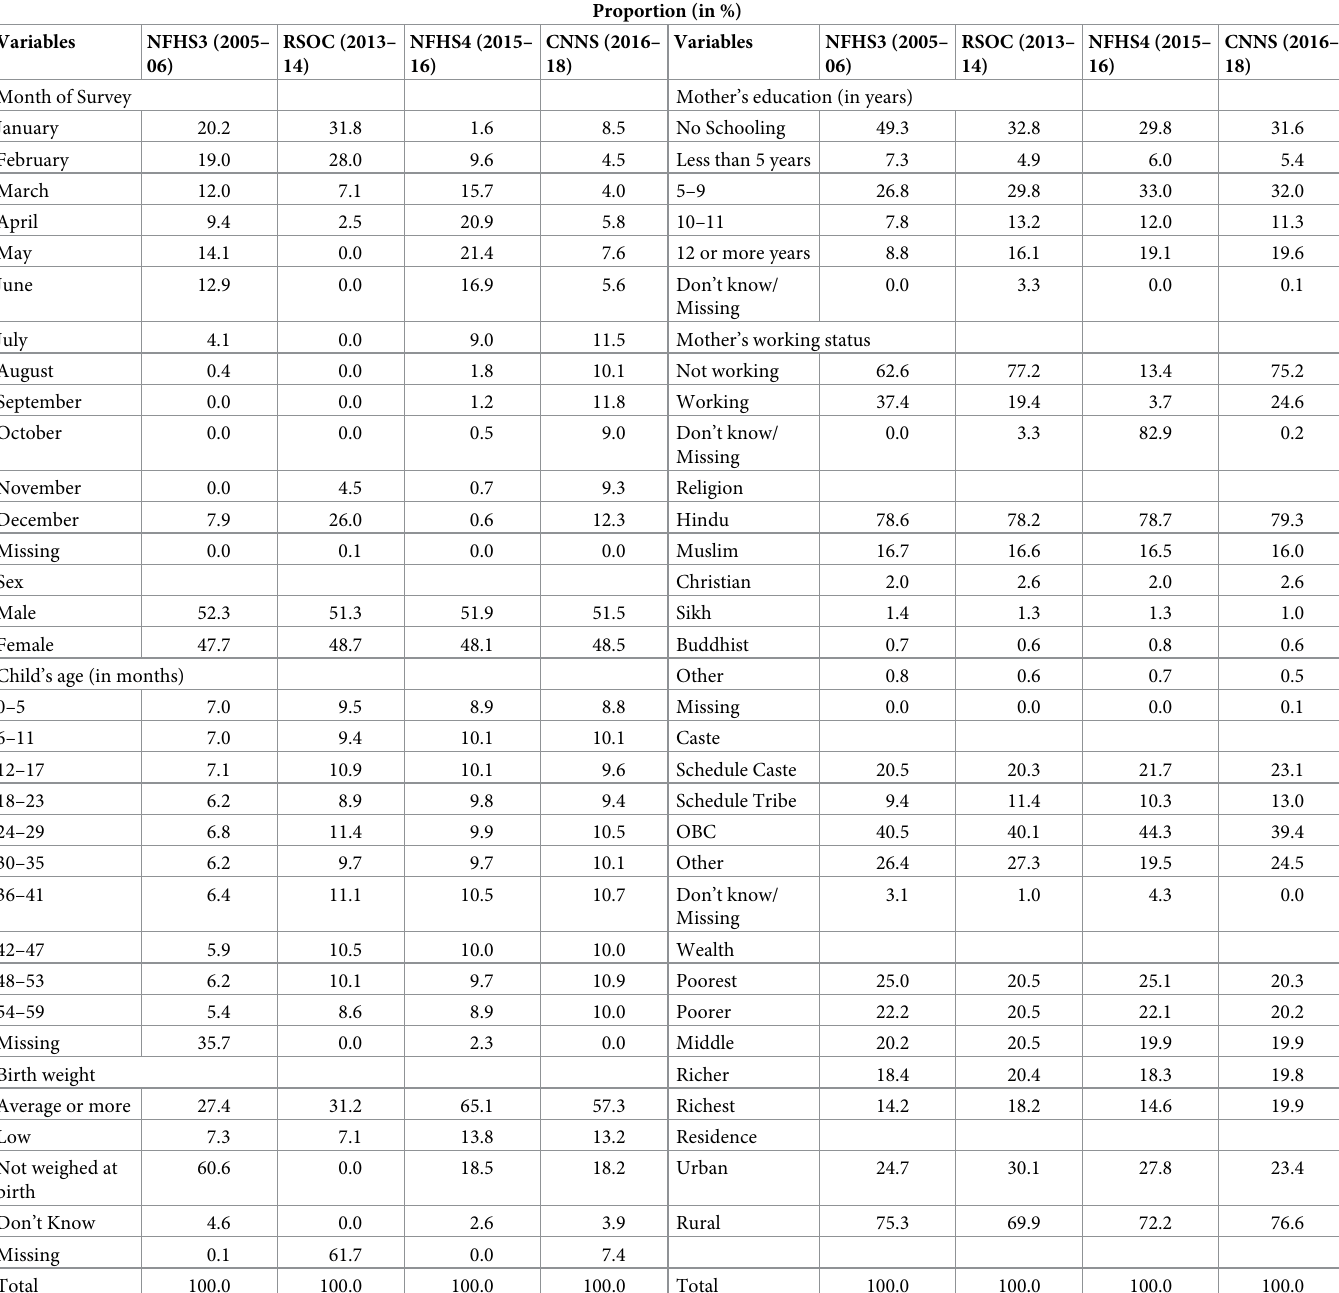
Table 1. Summary statistics of the covariates included in the analysis by